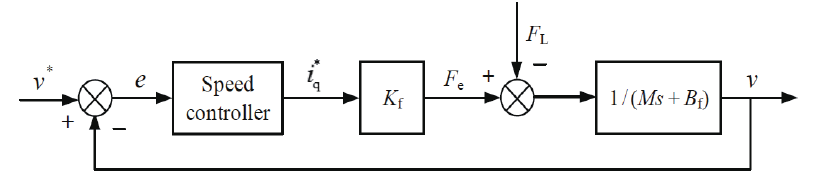
Figure 1. The simplified control diagram of the PMLSM servo